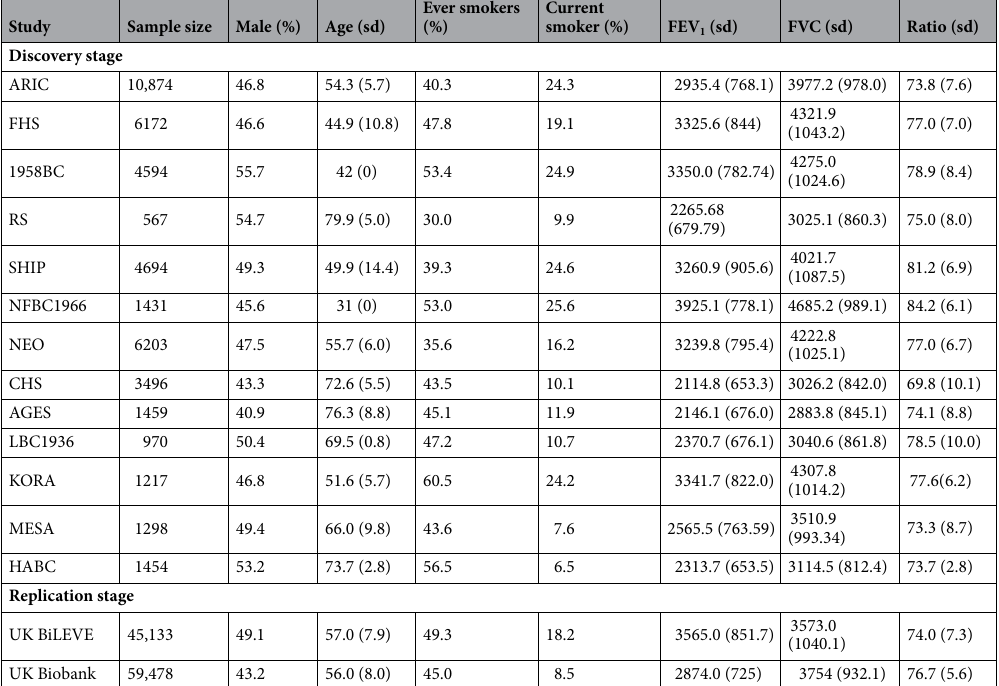
Table 1. Descriptive statistics for each participating cohort. FEV 1 and FVC are in unit of mL.